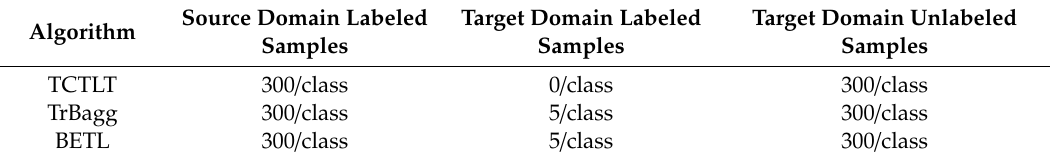
Table 1. Sample usage in each experiment. TCTLT: transductive label transfer; TrBagg: transfer bagging; BETL: bagging-based ensemble transfer learning.